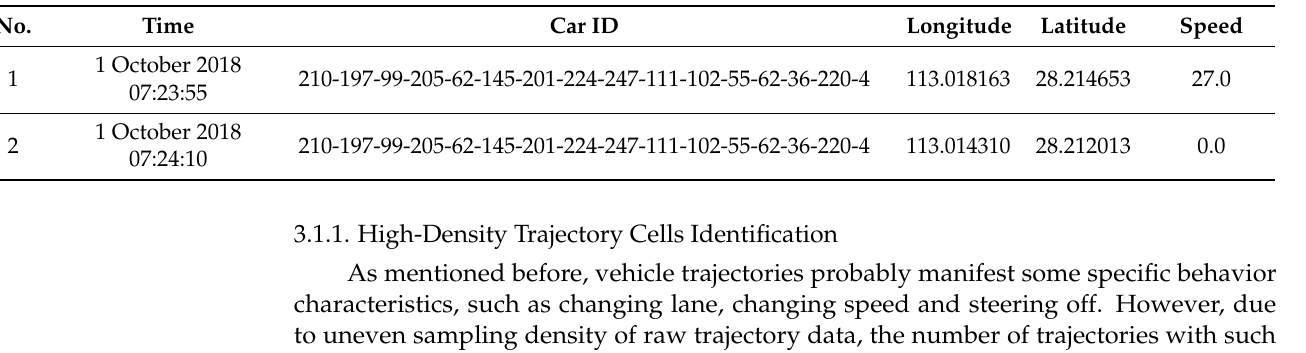
Table 1. The main information in raw trajectory